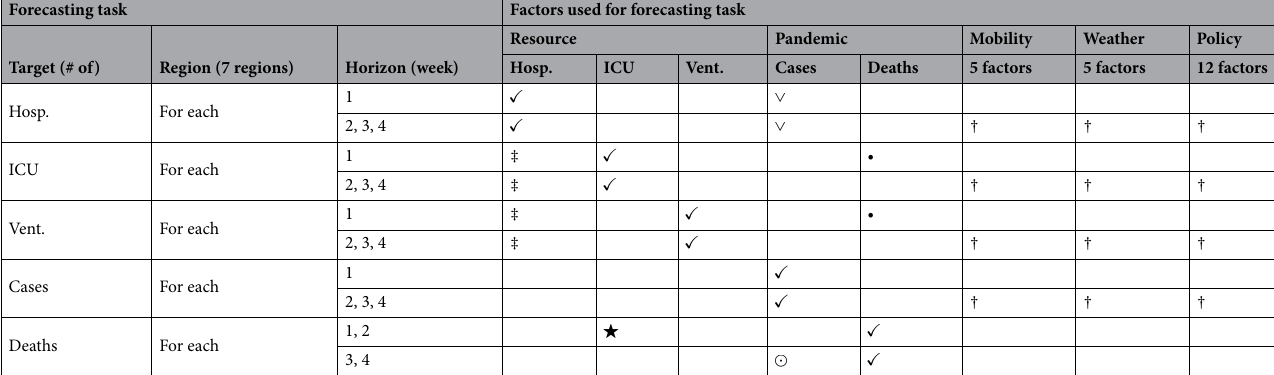
Table 3. The factors used for various target-region-horizon-specific forecasting tasks. For each cell with a symbol, the factor (in this cell’s corresponding column) is used for forecasting the target (in this cell’s corresponding row). The same symbols indicate that the forecasts are made under the same model assumption; see Model’s Input discussion in “Methodology” section.